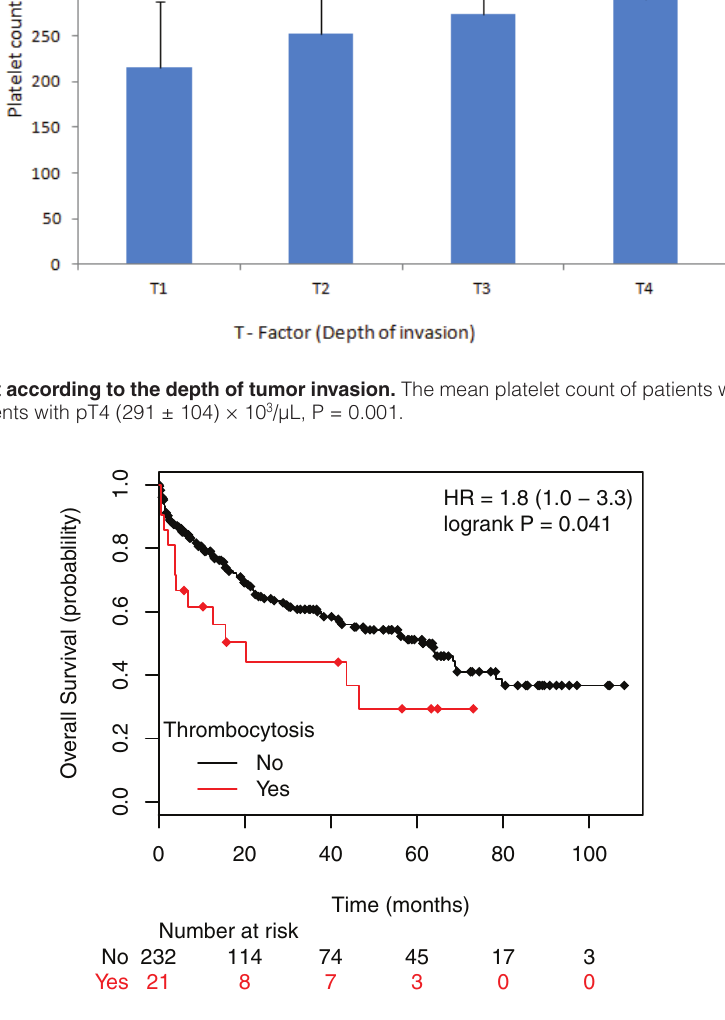
Figure 2. Overall survival plots of patients with stage I to stage III colorectal cancer according the preoperative platelet counts. Patients were allocated into two groups: with thrombocytosis, PLT ≥ 400 × 10 3 /µL (labeled as Exceeds) and without thrombocytosis) PLT < 400 × 10 3 /µL (labeled as Normal). The patients with thrombocytosis have a hazard ratio of 1.8 compare to the patients without thrombocytosis (P<0.041).